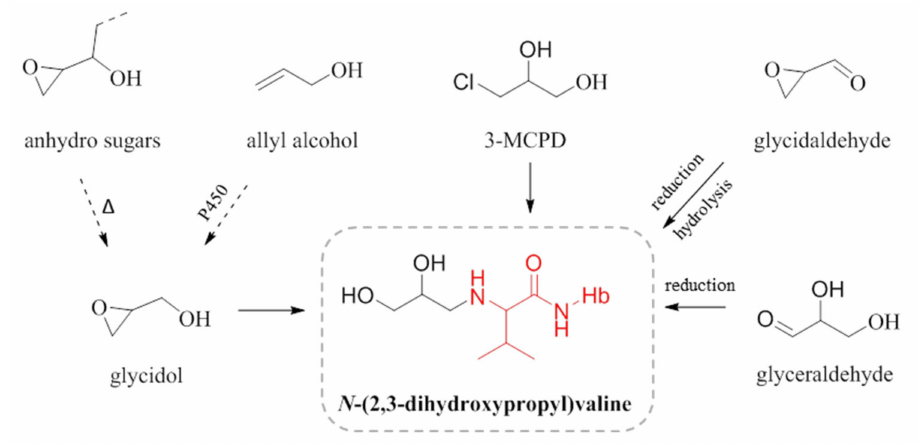
Figure 5. Examples of possible precursors to N -(2,3-dihydroxypropyl)valine c.f.